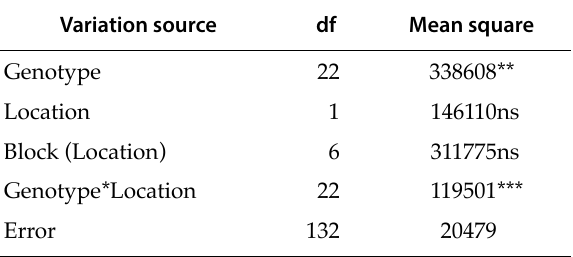
Table 4. Combined analysis variance of ascochyta blight severity (measured as Area Under the Disease Progress Curve) of 23 chickpea genotypes growing at two Tunisian locations (Oued Béja and Oued Méliz).